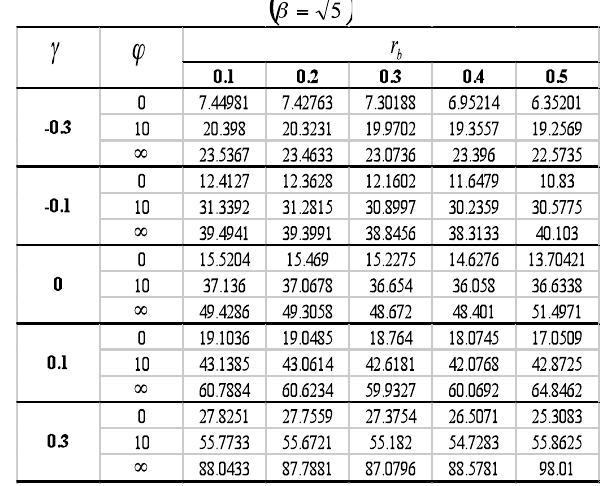
Table 6. load factor variation with edge elastically restrained